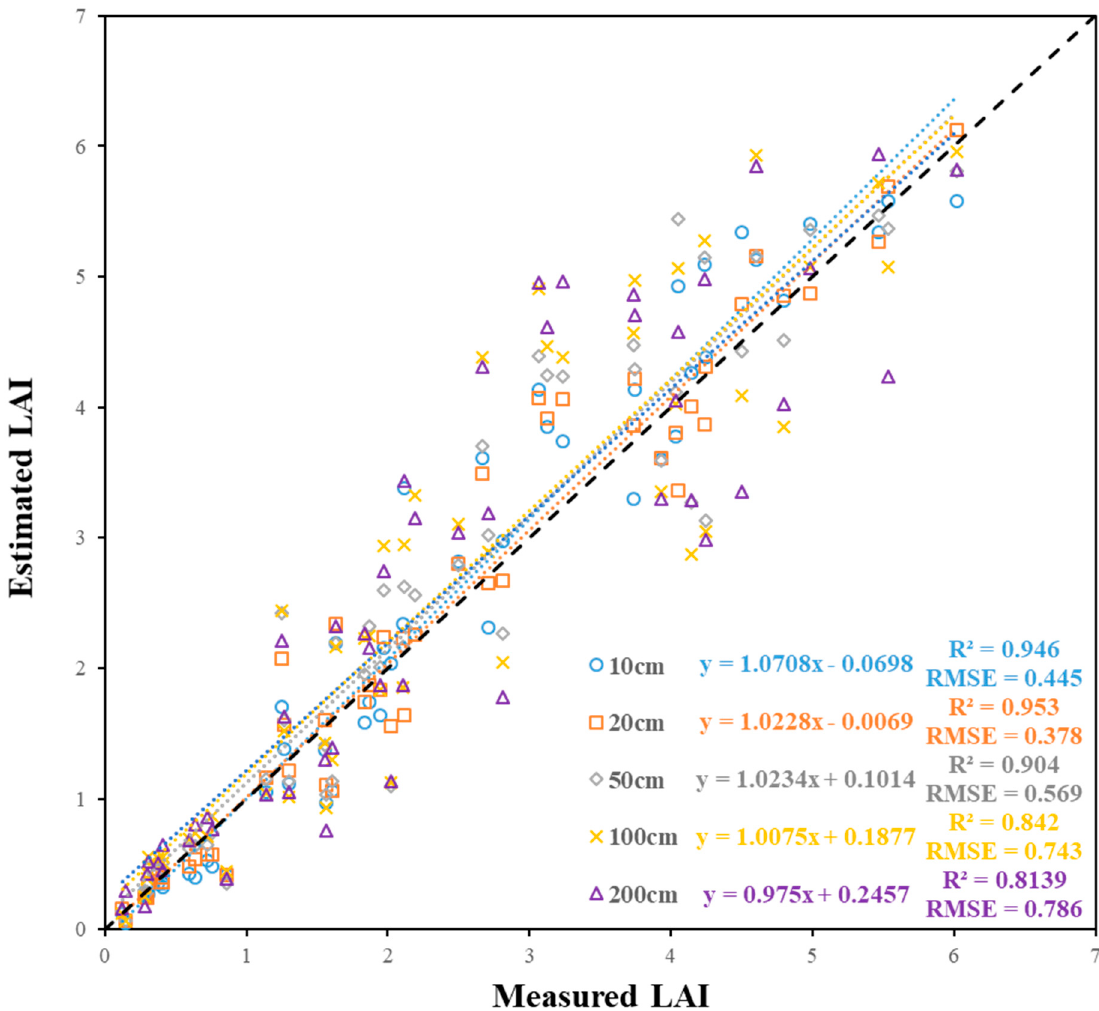
Figure 9. Fitting equation and evaluation index between the measured LAI and the estimated value by the modified gap fraction model based on the LAI max threshold at various periods of cotton under different calculation grids in experiment A (note: the black dotted line is the 1:1 line).